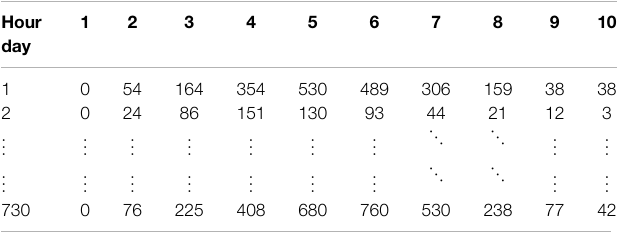
TABLE 1 | Representation of irradiance data (W/m taken for 10 h for 2 years (730 days). Hour